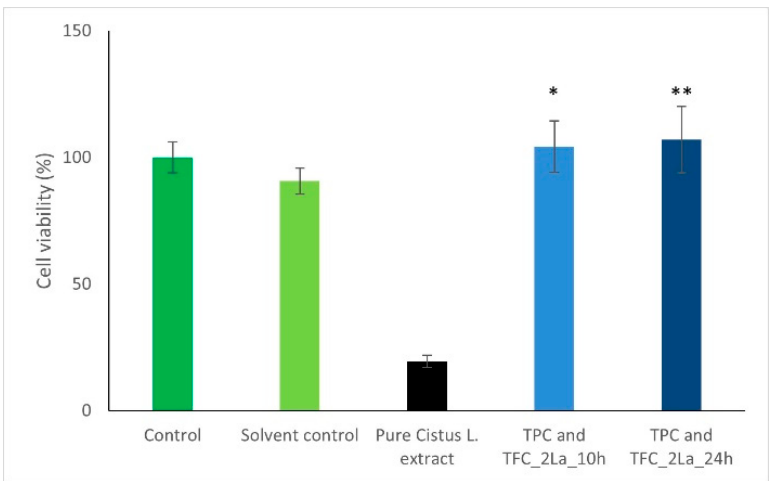
Figure 6. Keratinocytes (Ker-CT) cell line viability measured using 3-(4,5-dimethylthiazol-2-yl)-2,5-diphenyltetrazolium bromide (MTT) assay after 24 h of incubation: Control—keratinocytes cultured in standard medium; Solvent control—control, in which the influence of solvent on viability of keratinocytes was evaluated (medium diluted with water); Pure Cistus L. extract— Cistus L. extract used for Solution A preparation; total phenolic content (TPC) and total flavonoid content (TFC)_2La_10h— Cistus L. extract with the concentration of polyphenols and flavonoids released from plaster after 10 h; TPC and TFC_2La_24h— Cistus L. extract with the concentration of polyphenols and flavonoids released from plaster after 24 h. The statistical analysis was performed using one-way ANOVA—Sidak’s test. * p ≤ 0.05; ** p ≤ 0.01.